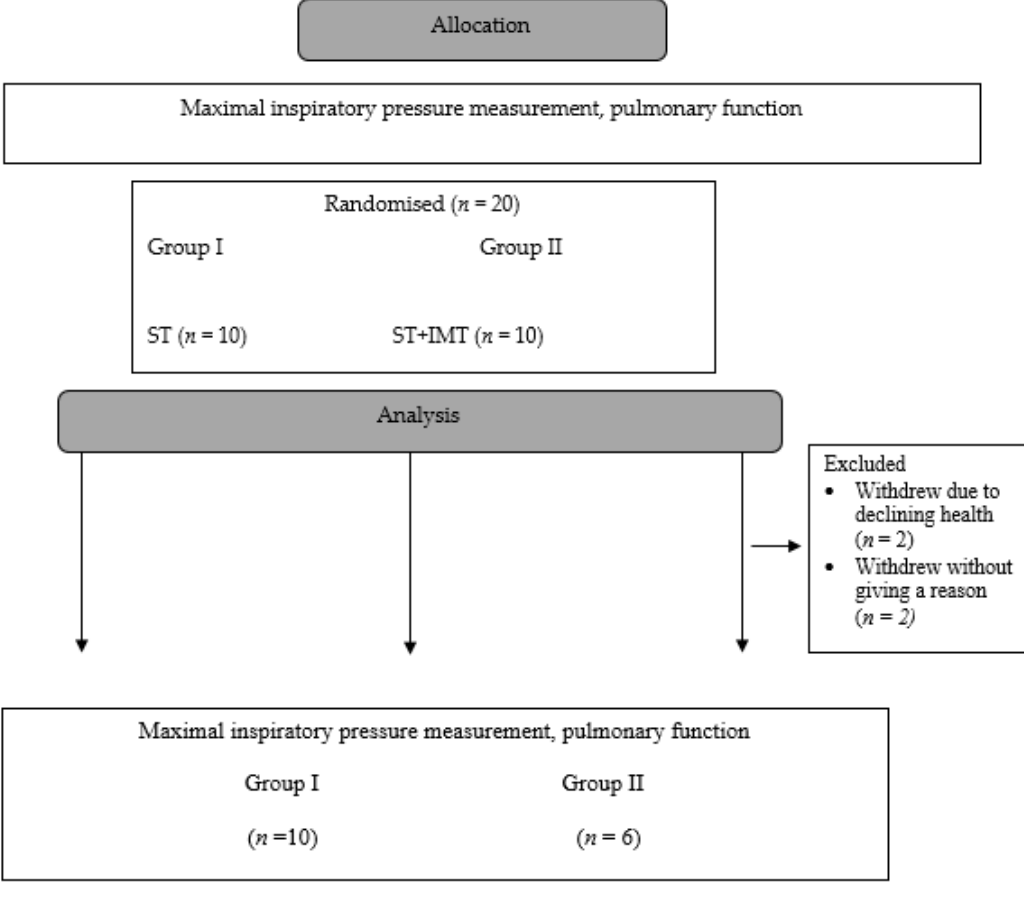
Figure 1. Design and flow of participants throughout the study. ST—swimming training; IMT—inspiratory muscular training.